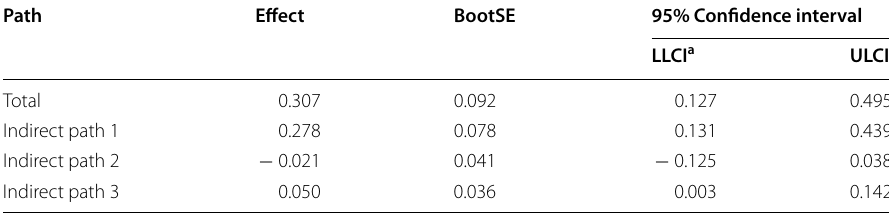
Table 2 Indirect effects of touch simulation on VR store satisfaction